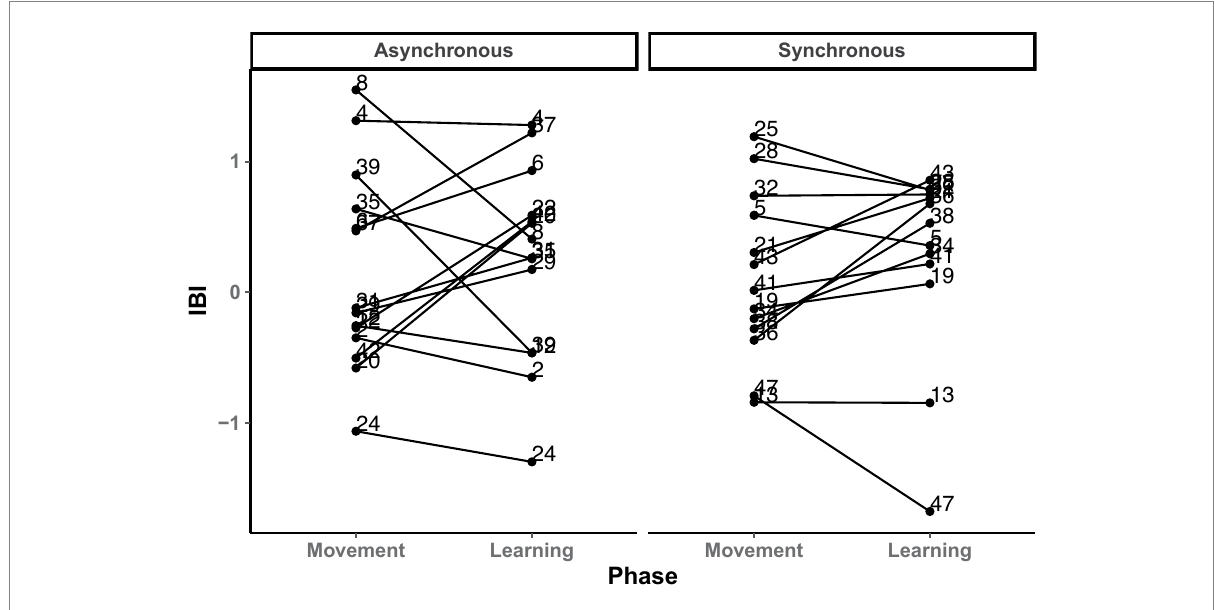
FIGURE 6 Change in individual participants’ IBI levels across (a)synchronous movement and learning phases, separated by asynchronous and synchronous